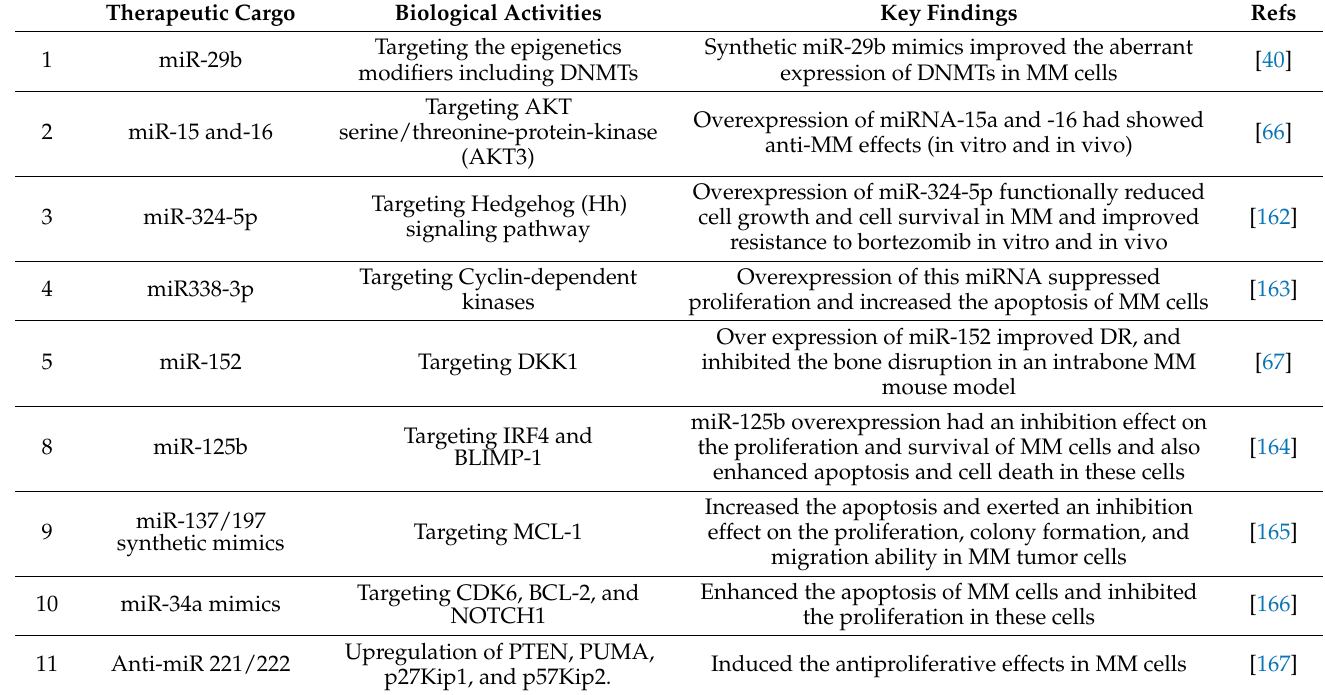
Table 3. The therapeutic effects of artificial inhibition/overexpression of the miRNAs in MM. Therapeutic Cargo Key Findings